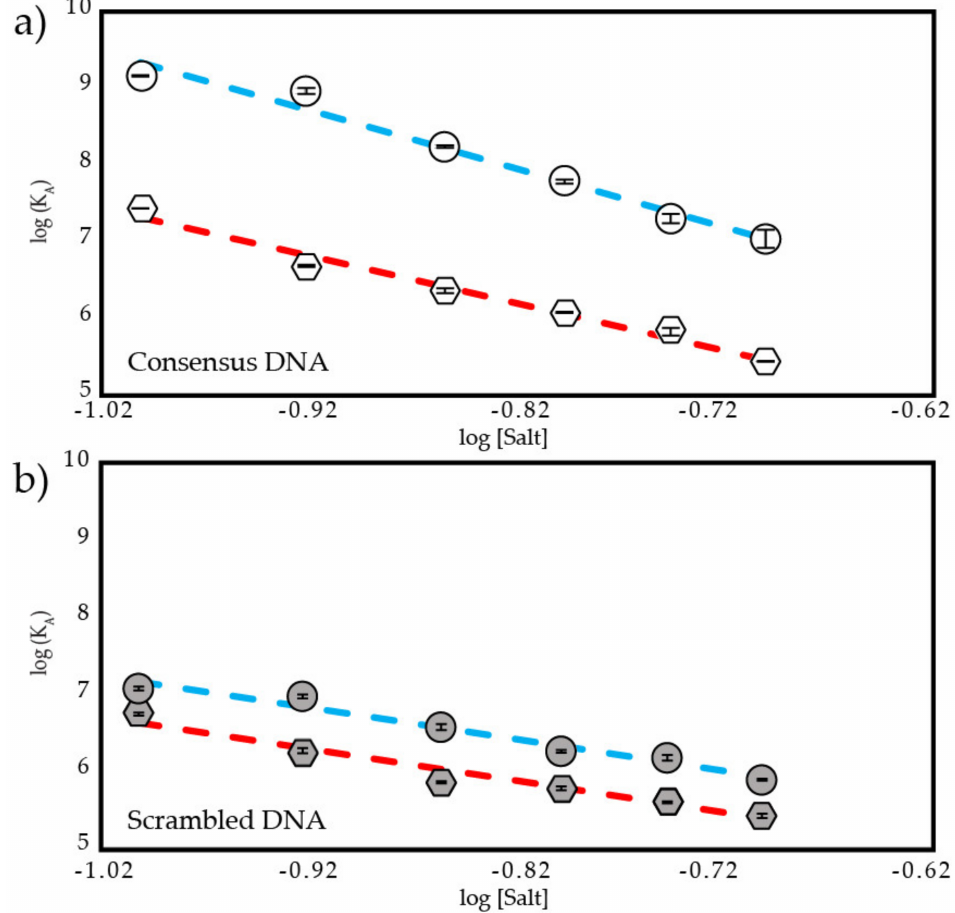
Figure 5. Salt-dependent binding affinity of DBD and ND WT. Plot of log (K A ) vs. log [Salt] from 125–225 mM IS of ( a ) DBD and ND WT binding to consensus DNA where is DBD, is ND WT, ( b ) DBD and ND WT binding to scrambled DNA where is DBD, is ND WT. R 2 values for all fit lines are between 0.96 and